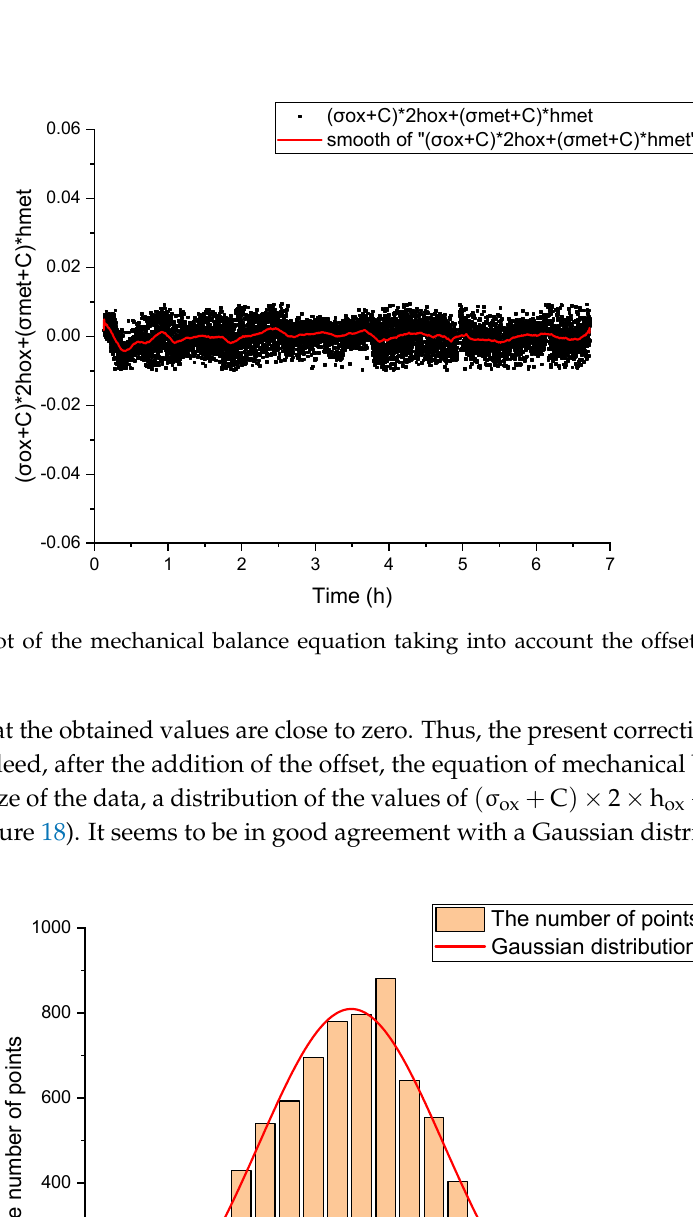
Figure 18. Number of points versus the value of (σ  + C) × 2 × h  + (σ  + C) × h  for R0.58.